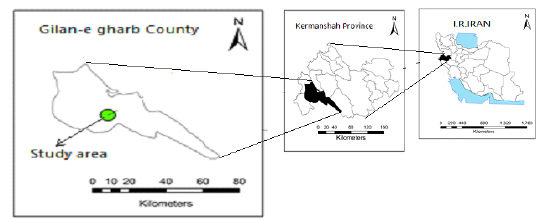
Fig. 2. Study area (Kaseh-Garan).